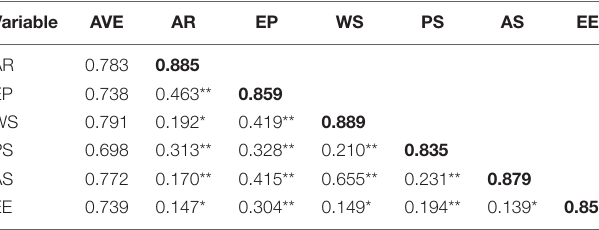
TABLE 2 | Pearson’s correlation coefficient matrix for study variables.